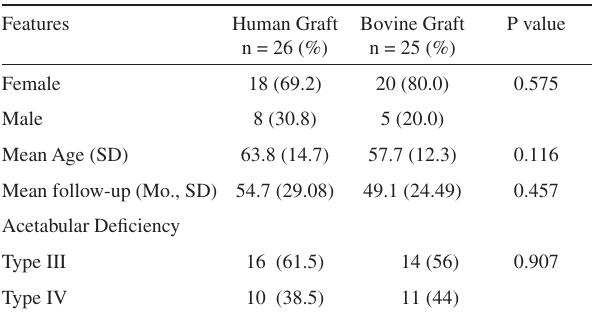
Table 1 - Clinicopathologic characteristics of the